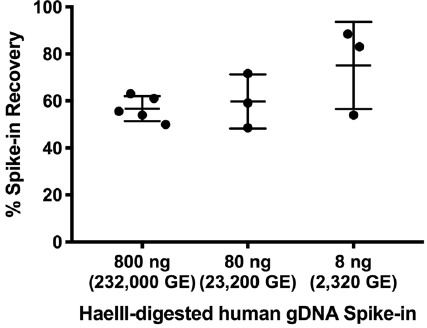
Figure 4. DNA isolation efficiency using the Norgen Stool DNA Isolation Kit. Across all samples (ranging from 800 to 8 ng of digested human gDNA spiked into stool slurries and carried through DNA isolation), the recovery of the spike-ins averaged 62%. Error bars represent standard